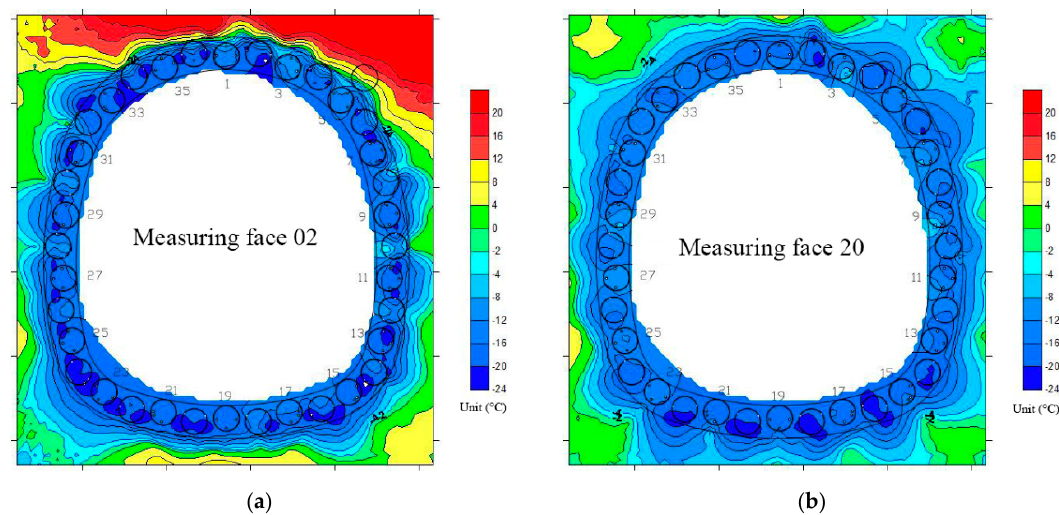
Figure 7. Cloud charts of the temperature field of typical measuring faces: ( a ) measuring face 02; ( b ) measuring face 20.